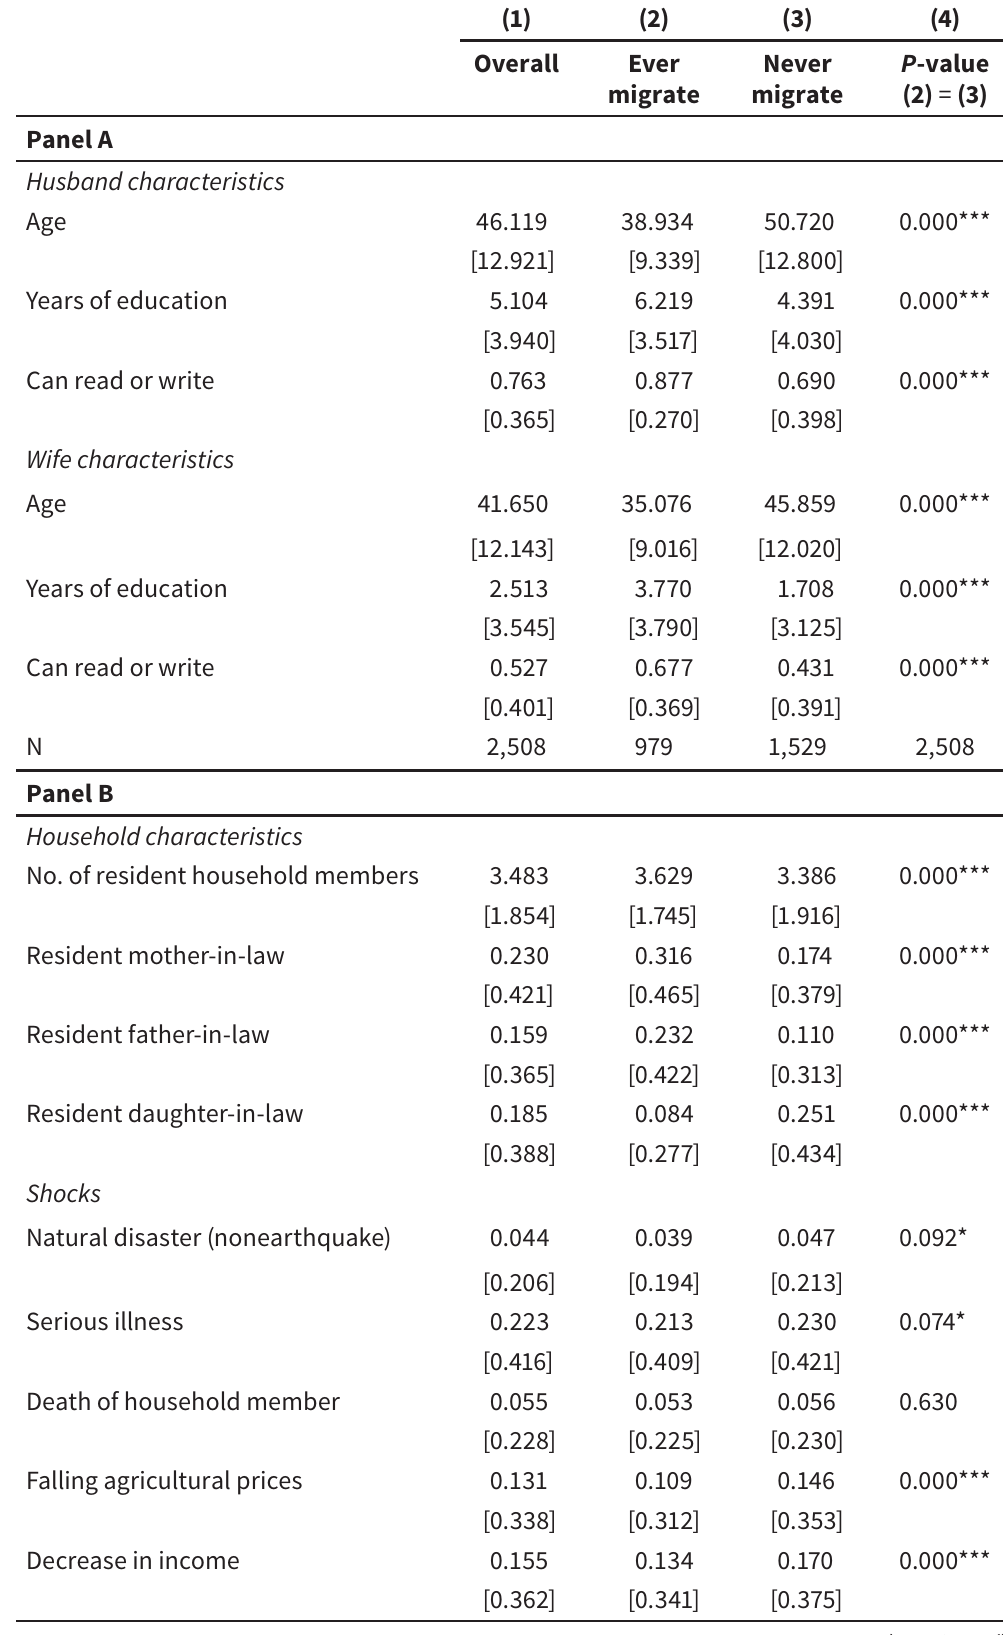
Characteristics by migrant